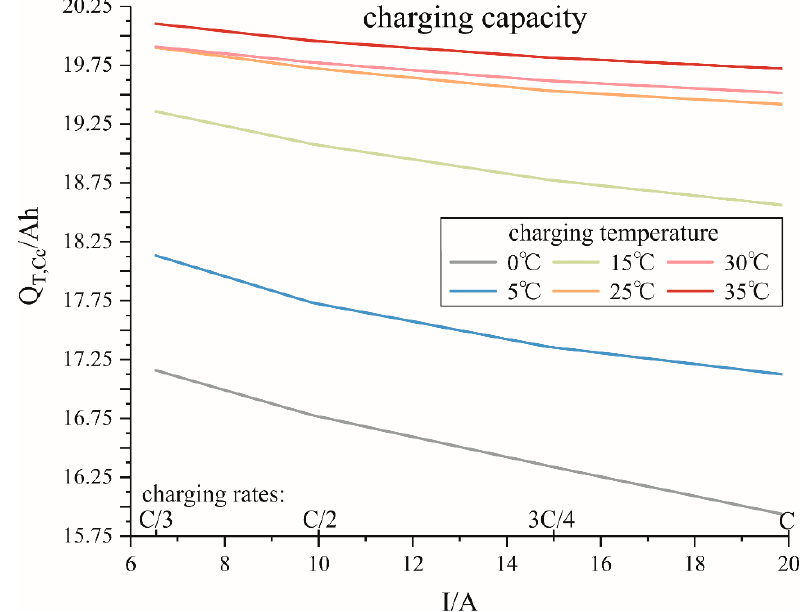
Figure 5. Evolution of the charging capacity as a function of rate at different temperatures in the range 0–35 °C.